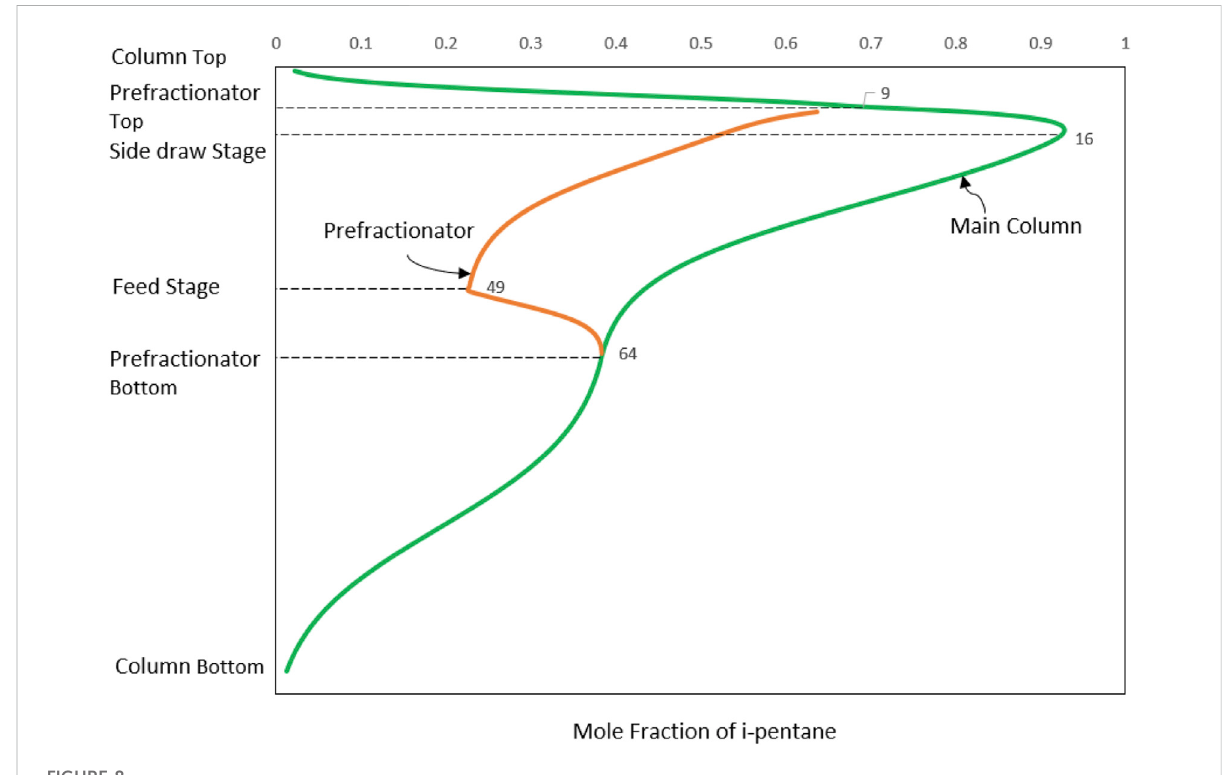
FIGURE 8 Composition pro fi les of i-pentane in the DWC for Example 2.